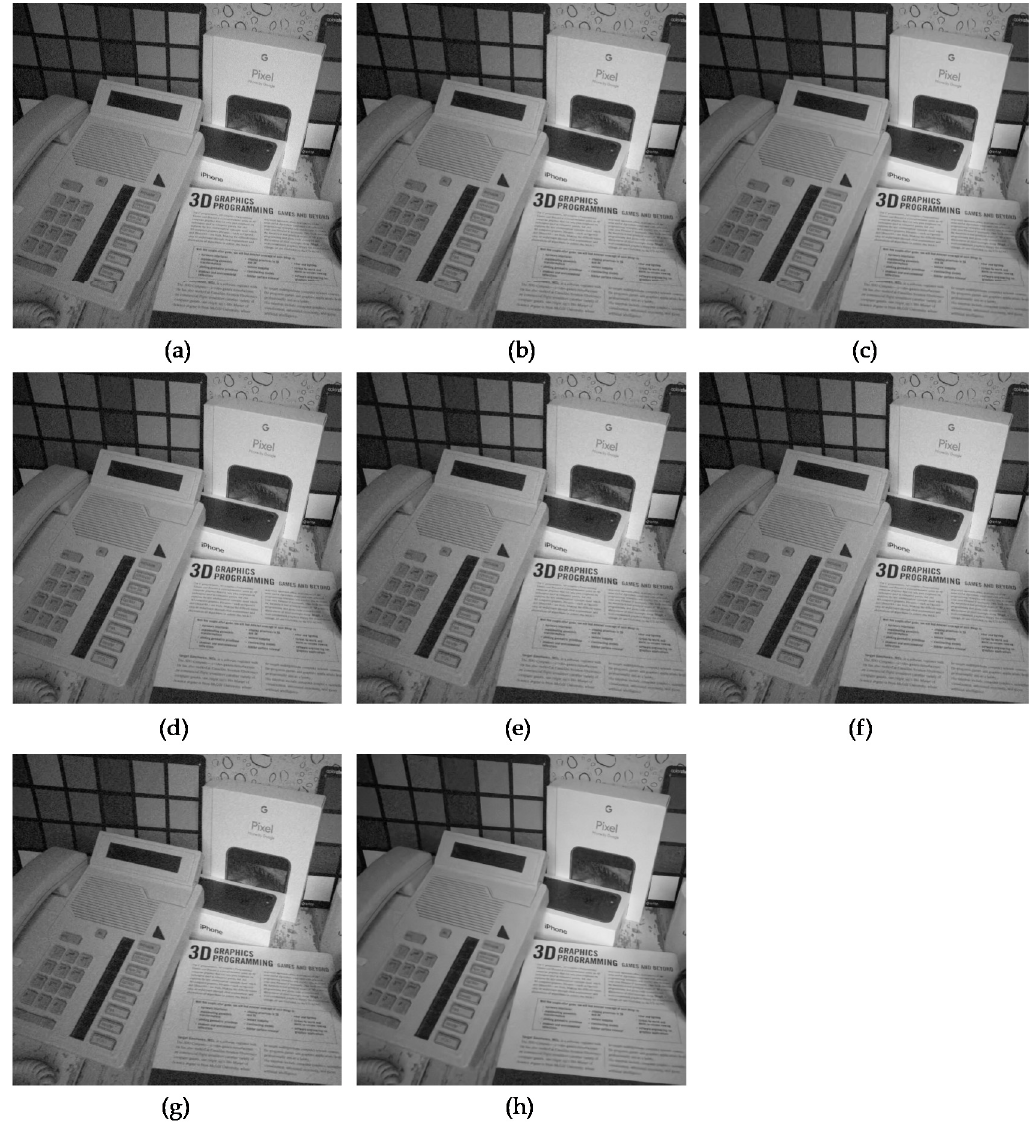
Figure 9. Comparison of the subjective visual quality for the image from the SIDD dataset, Desk. ( a ) Captured image using an iPhone 7 with ISO = 200 and exposure = 1/400 (BRISQUE = 46.81). ( b ) JPEG-coded image with q = 30 (BRISQUE = 28.98). ( c ) Result of BM3D [22] (BRISQUE = 22.20). ( d ) Result of SSRQC [23] (BRISQUE = 26.07). ( e ) Result of ARCNN [2] (BRISQUE = 24.35). ( f ) Result of DnCNN [4] (BRISQUE = 21.78). ( g ) Result of MWCNN [5] (BRISQUE = 24.11). ( h ) Result of SCENet (BRISQUE = 19.70).